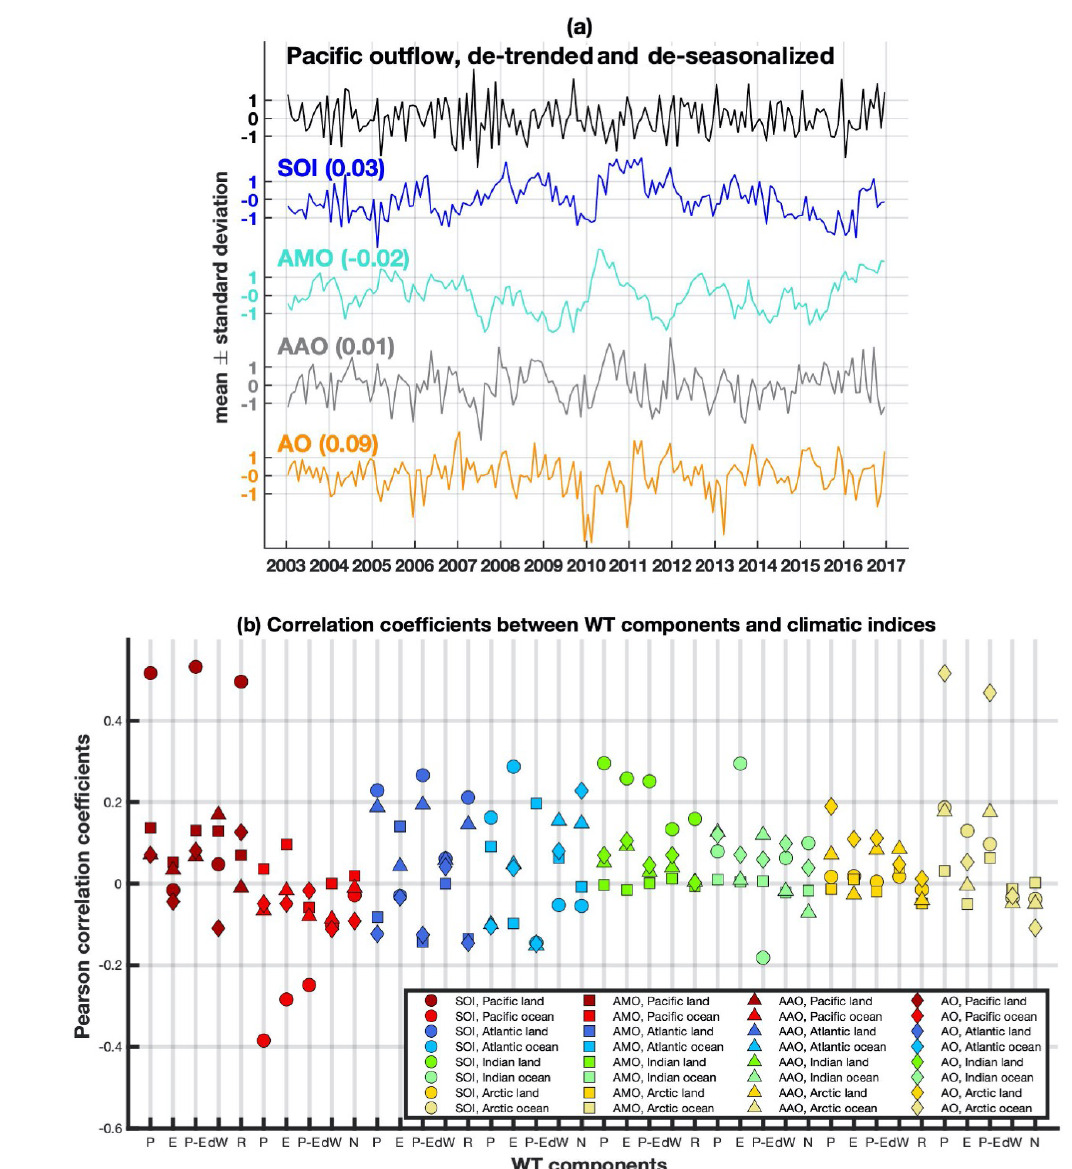
Figure 7. Pacific outflow and climatic indices for ENSO, AMO, AO, and AAO. (a) The time series of the Pacific outflow is de-trended and de-seasonalized. All time series are normalized to have unit variance. Values in parenthesis are the correlation coefficients between the corresponding climatic index and the Pacific outflow. (b) Correlation coefficients between de-trended and de-seasonalized WT components of different regions and the climatic